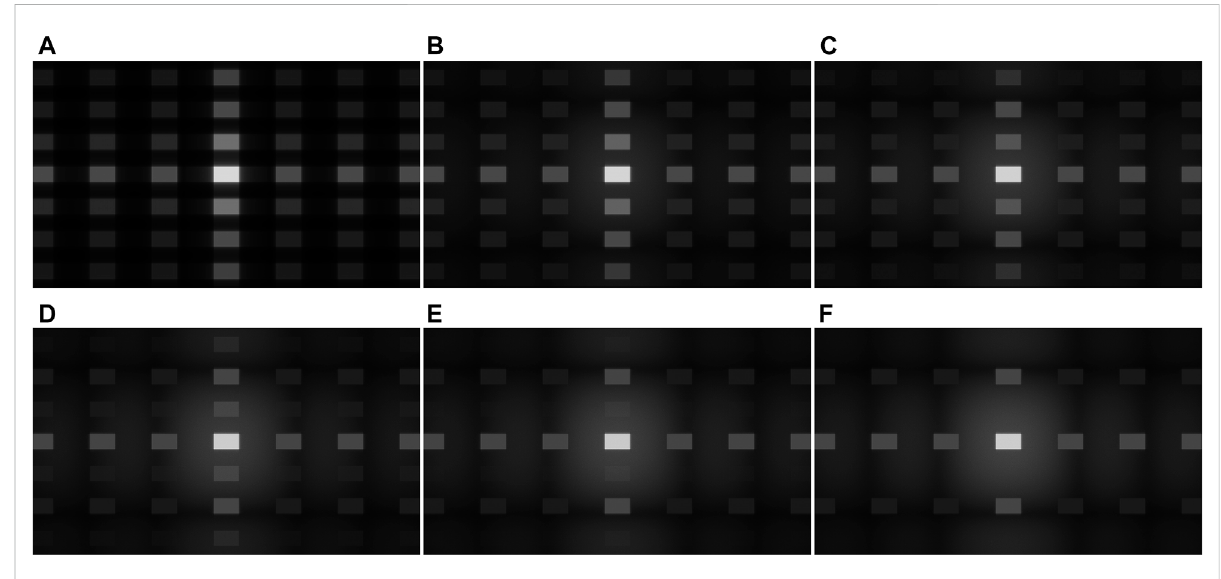
FIGURE 7 Diffraction patterns of rectangular phase gratings added with the random phase as the perturbation, the standard deviations of which are, respectively, (A) 0, (B) 0.36, (C) 0.73, (D) 1.09, (E) 1.45, and (F) 1.81.